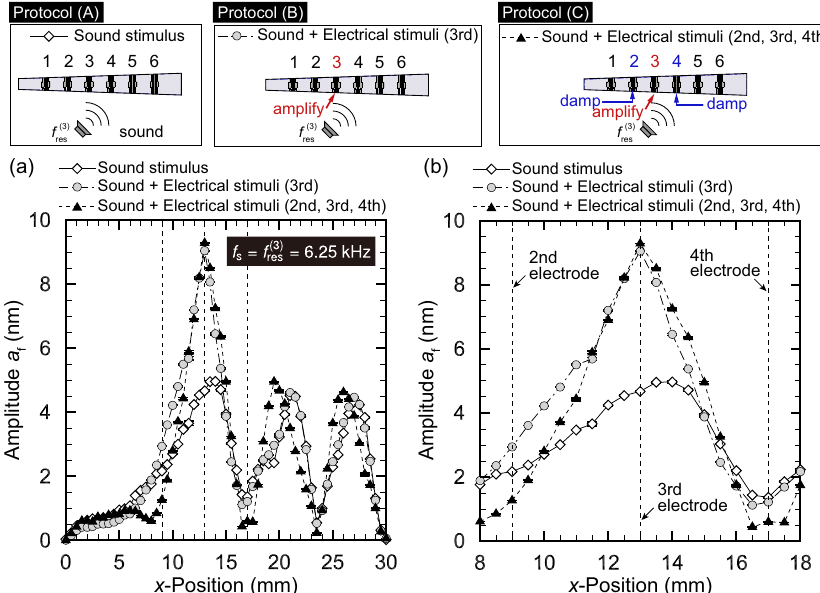
Figure 4. Vibration amplitude distribution for protocol (A): only sinusoidal sound stimuli with f s = 6.25 kHz; protocol (B): sound and electrical stimuli applied to the third electrode; and protocol (C): sound and electrical stimuli applied to the second to fourth electrodes. ( a ) Entire view and ( b ) magnified version near x ( 3 ) . Protocol (B) succeeded in amplifying a f at resonant position x ( 3 ) = 13